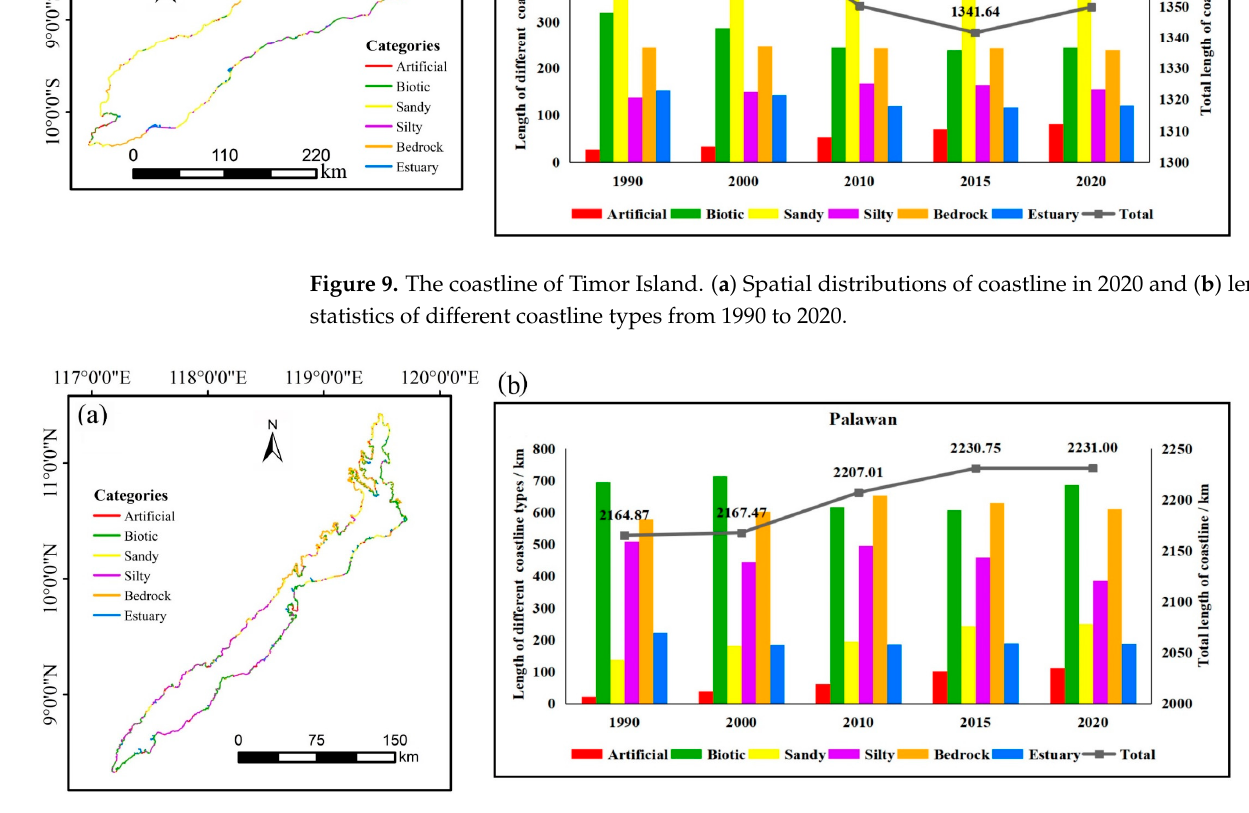
Figure 10. The coastline of Palawan Island. ( a ) Spatial distributions of coastline in 2020 and ( b ) length statistics of different coastline types from 1990 to 2020. Table 4. Overall changes of coastline in three tropical islands from 1990 to